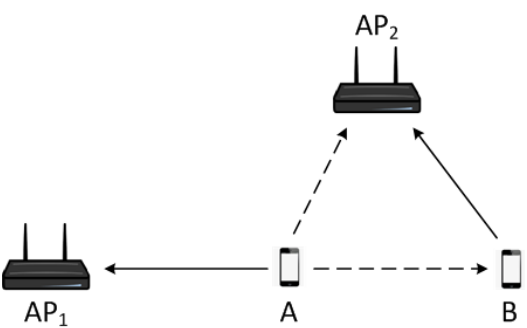
Figure 4. A scenario where node B transmits in parallel with node A according to PSR, but node B’s packet is lost due to low SNR at AP 2